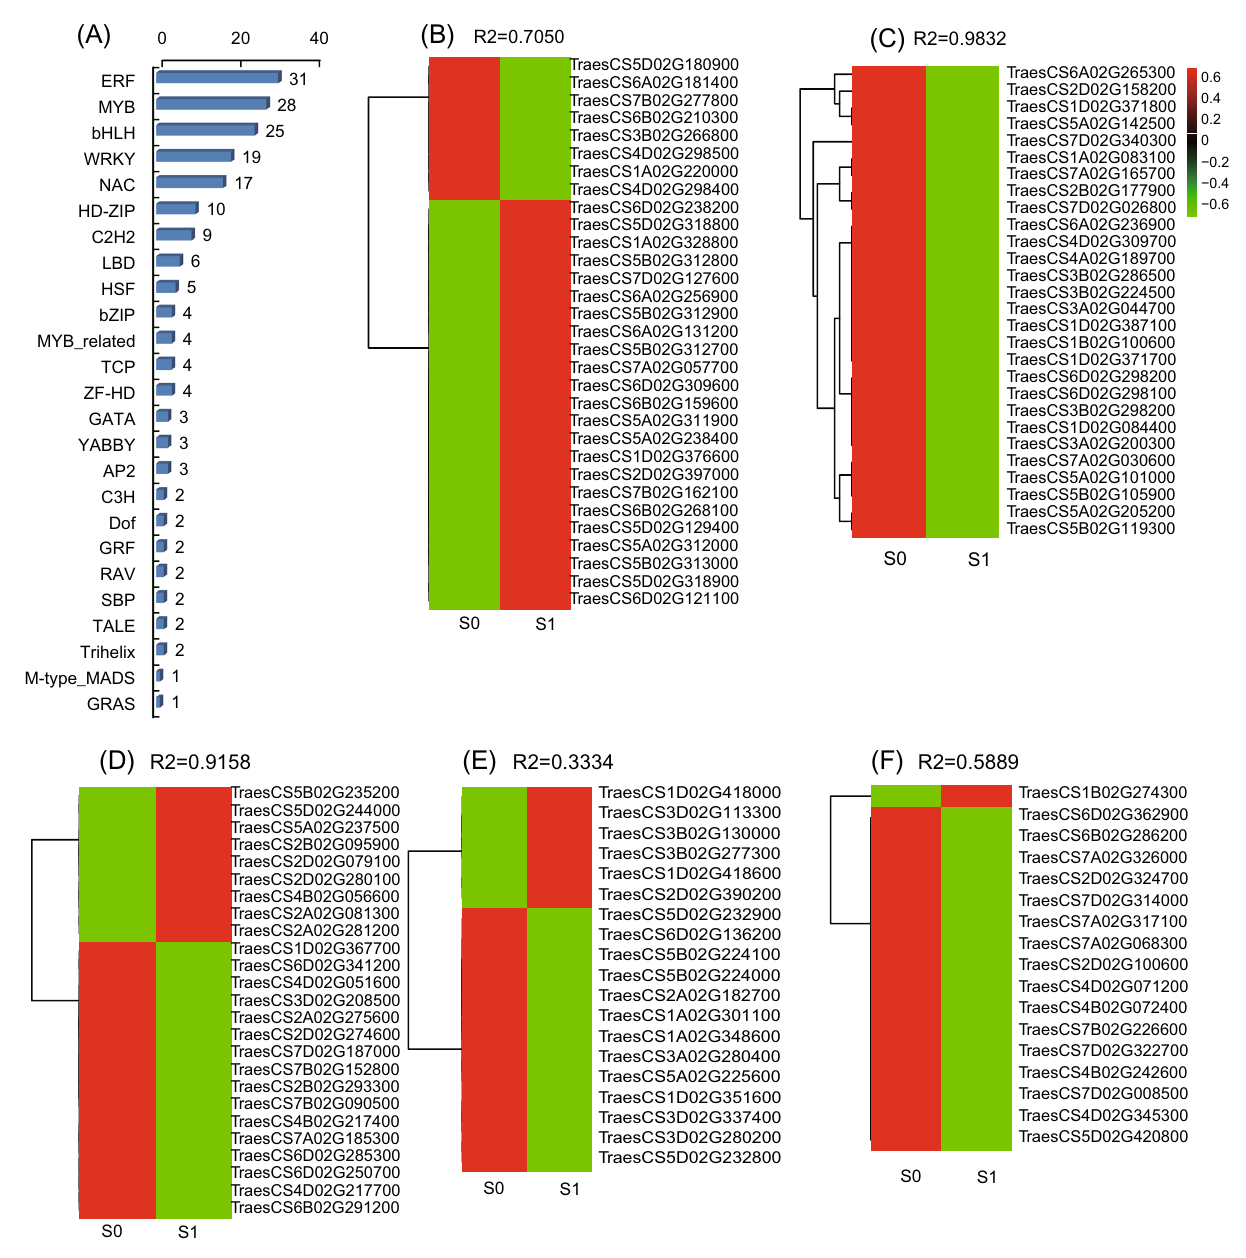
Figure 4. Functional classification and expression profiles of TFs. ( A ) Distribution of differentially expressed TFs in gene families. ( B ), ( C ), ( D ), ( E ), and ( F ) indicate expression profiles of ERF, MYB, bHLH, WRKY, and NAC TFs, respectively.